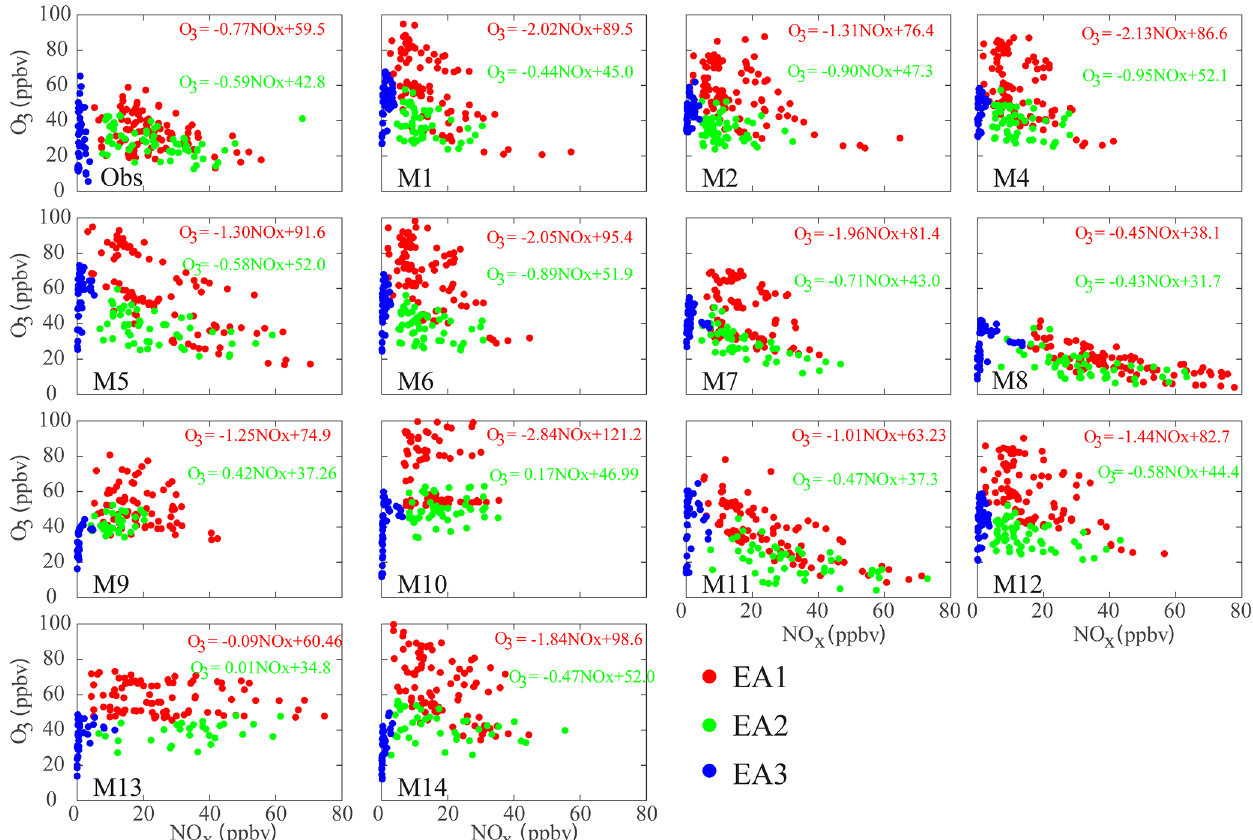
Figure 10. Scatterplots for monthly daytime (08:00–20:00LT) surface NO x and O 3 for each station in EA1 (red), EA2 (green) and EA3 (blue) in May–October, for observations (Obs) and models. Also shown are the linear regression equations for NO x and O 3 in EA1 (red) and EA2